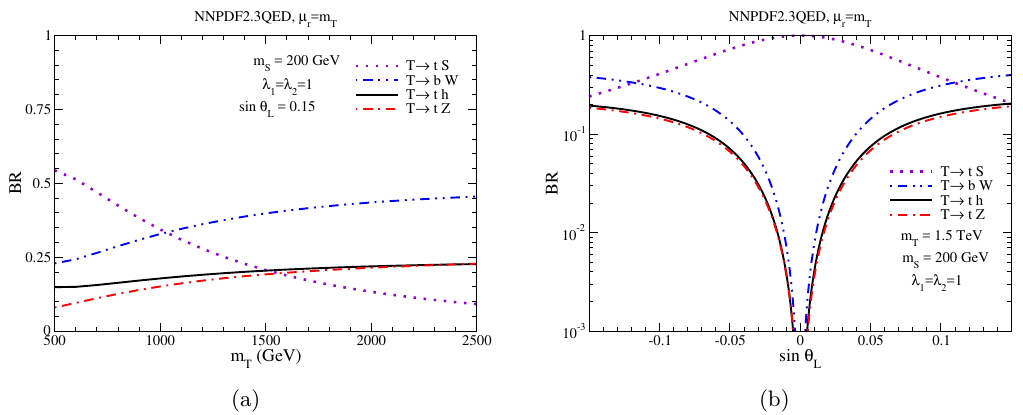
Figure 8 . Branching ratios of the top partner as a function of (a) top partner mass and (b) mixing angle sin (cid:18) L for (violet dotted) T tS , (blue dash-dot-dot) T ! (red dash-dot) T tZ . For (a) the remaining parameters are set at (cid:21) 1 ; 2 = 1, m S = 200 GeV, !